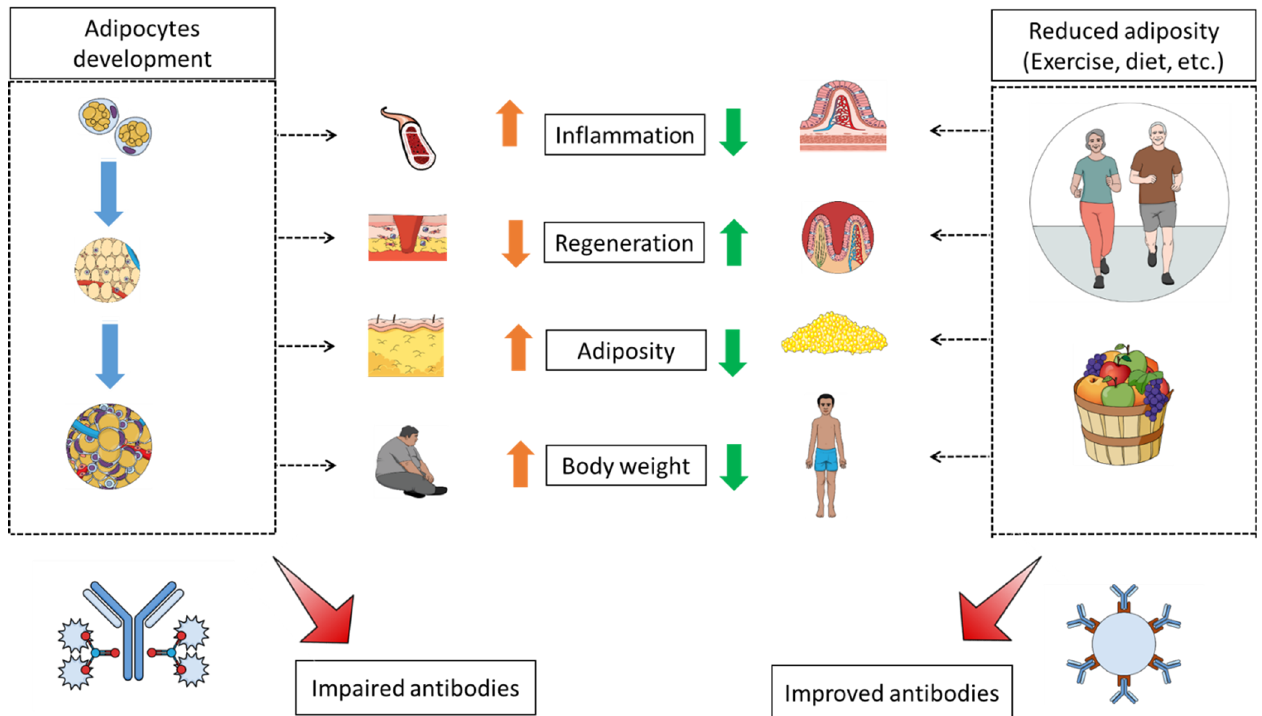
Figure 1. Antibody patterns and immunity performance between increased adiposity and exercise. Immunity functions and antibody-related patterns such as inflammation and regeneration are negatively impacted by adiposity development but corrected/improved by exercise and other adiposity-reducing approaches.